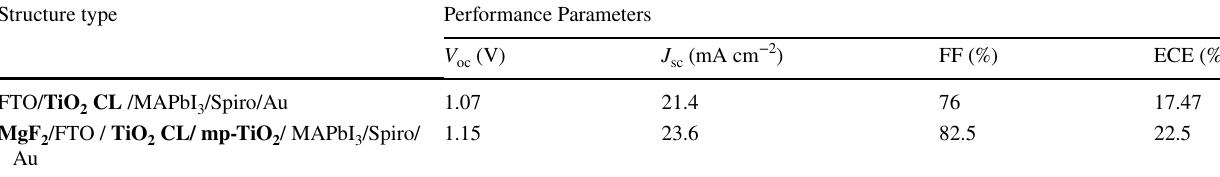
Table 2 A comparison of photovoltaic performance parameters of single‑junction PSCs extracted from J-V characteristic curves Structure